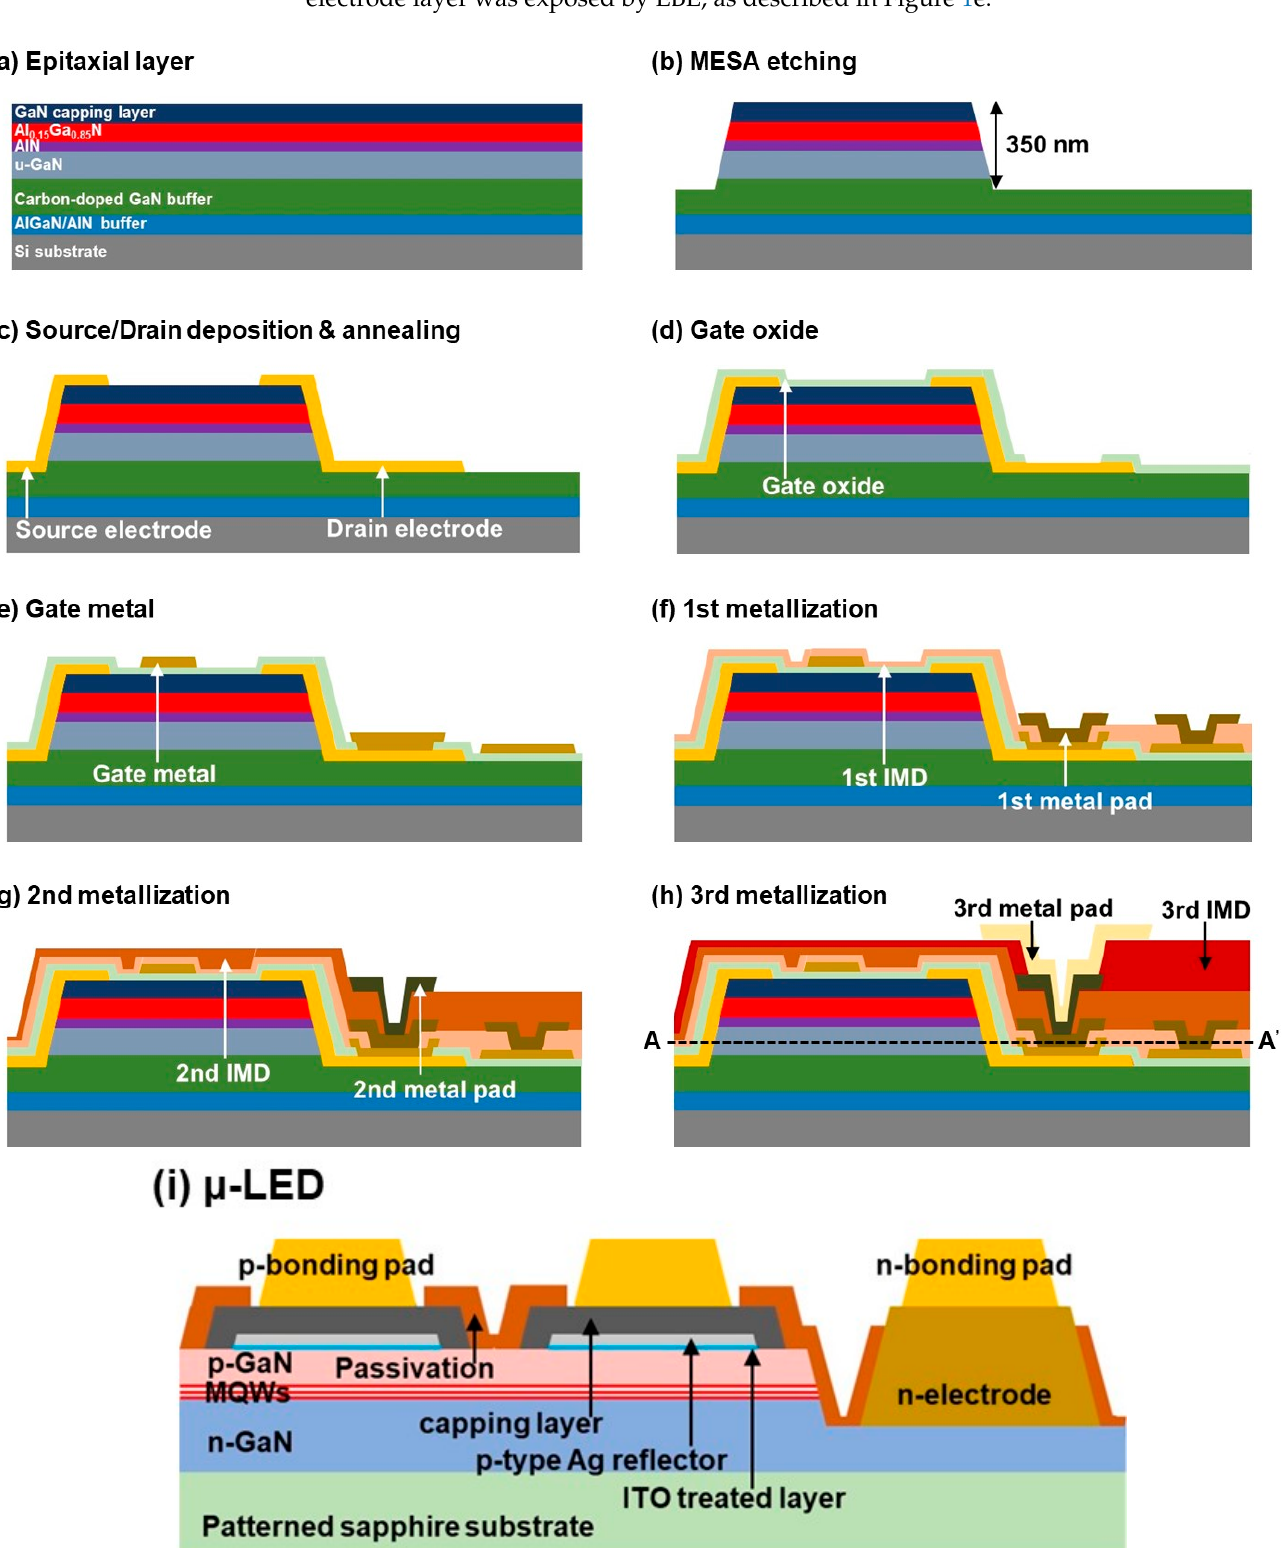
Figure 1. ( a–h ) Schematic fabrication steps of an HEMT device. ( i ) Basic epitaxial structure of a fabricated μ -LED.